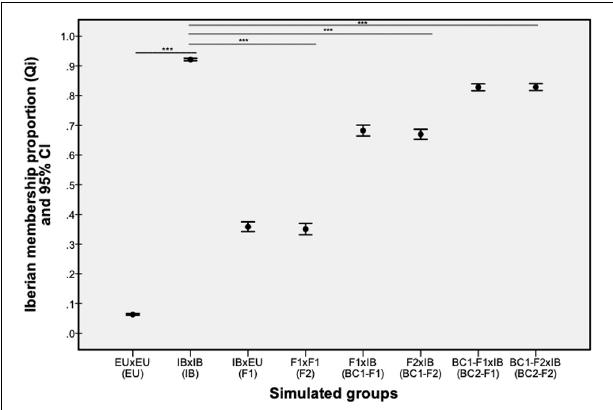
FIGURE 2 | The proportion of Iberian membership (qi) values estimated using the STRUCTURE program for the admixed generations of parental (native – IB; non-native – EU) and hybrid (F1, F2, BC1, and BC2) genotypes simulated by the HYBRIDLAB program. Bars with asterisks represent the statistically significance differences observed between simulated native red deer and non-native/hybrid classes ( p -value < 0.001).